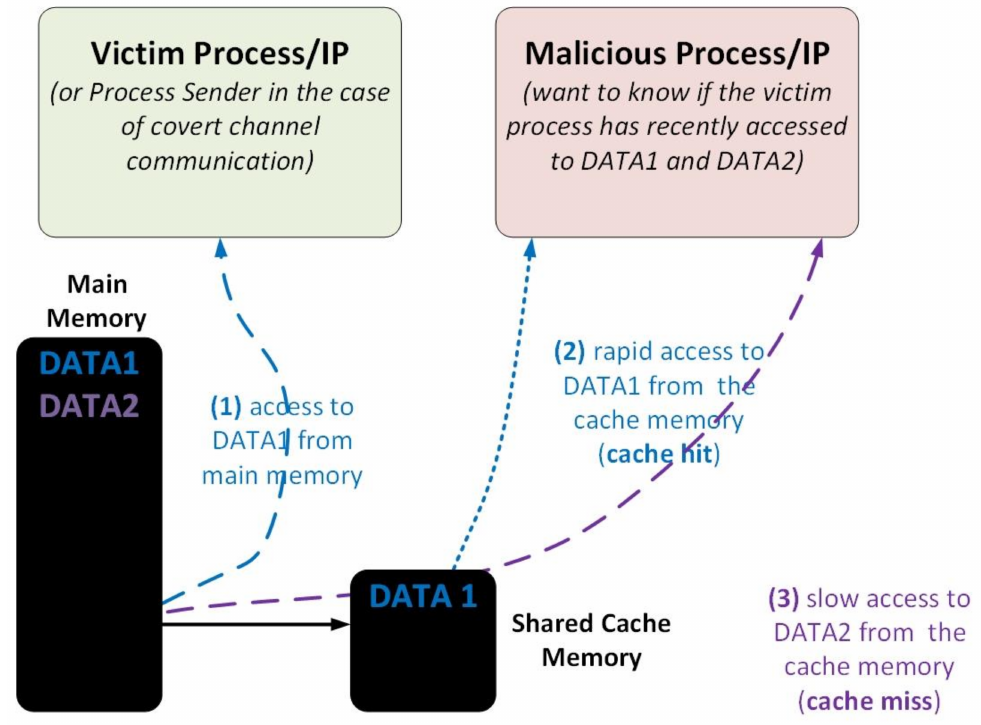
Figure 3. Principal of cache timing attacks: the malicious process accesses DATA1 and DATA2 and detects a cache hit for DATA1 and a cache miss for DATA2 and concludes that the victim process has recently accessed DATA1 . After detection, the malicious process flushes the cache to perform a new